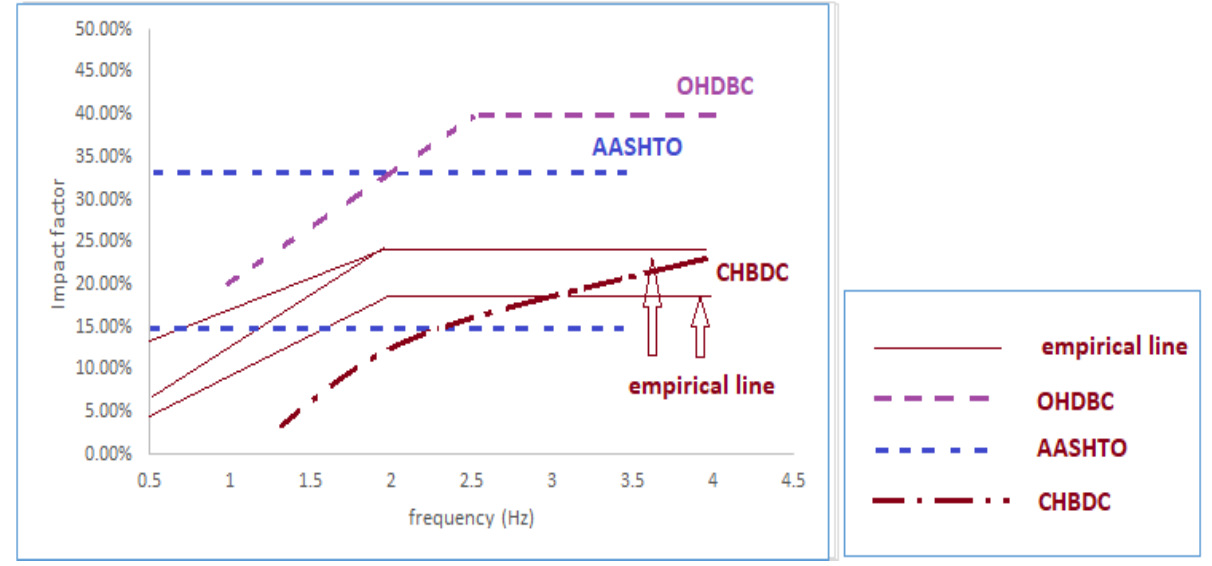
Fig. 13. Comparison of different methods of determining impact